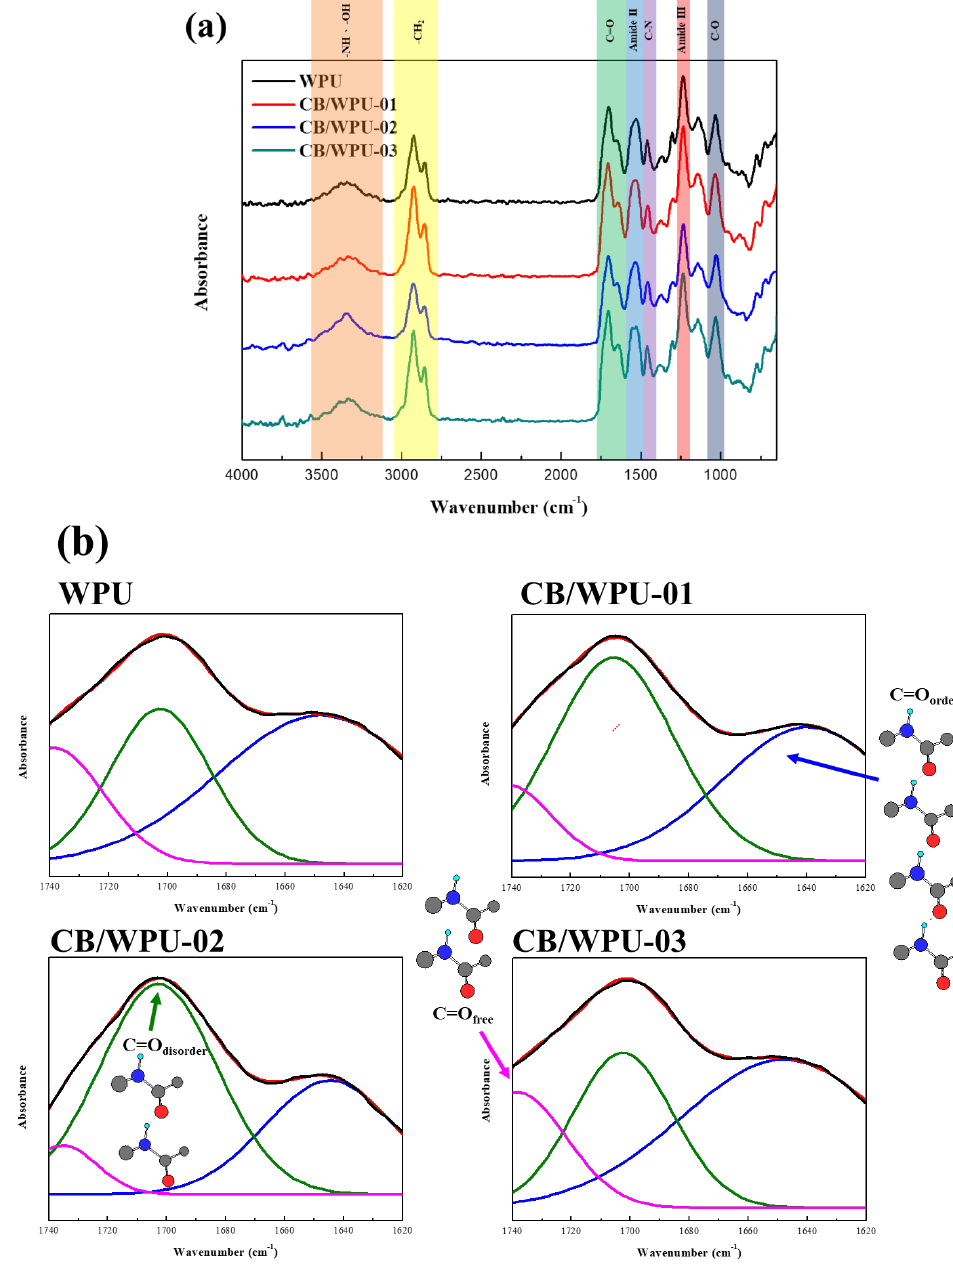
FT-IR spectra of the CB / WPUs at the wavenumber range of ( a ) 4000–650 cm − 1 , ( b ) 1740–1620 cm − 1 . (C = O order as blue line; C = O disorder as green line; C = O free as pink line).